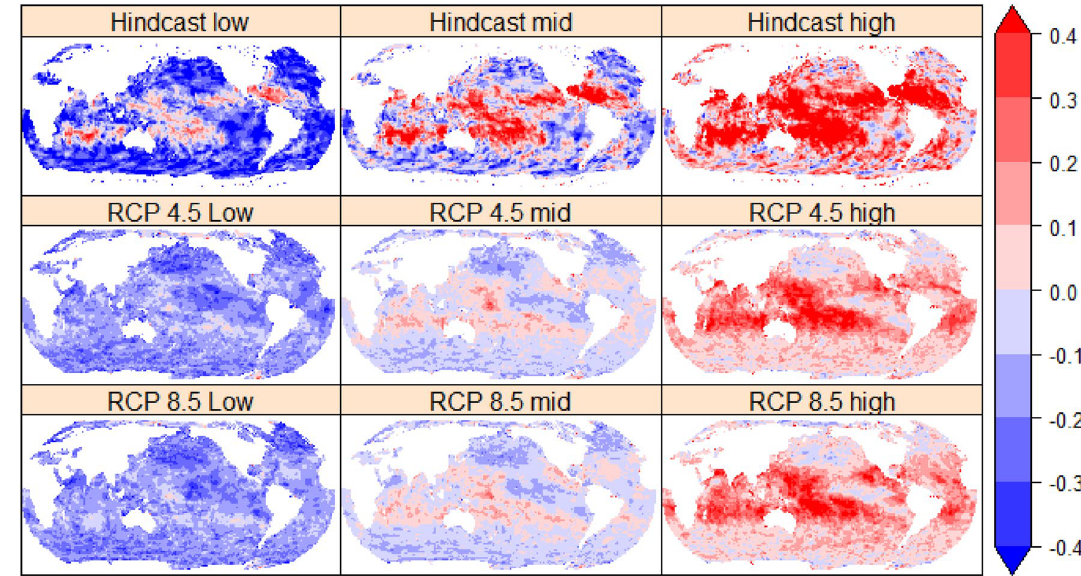
Figure 2. Estimated range of the GEV shape parameter for the full periods of the hindcast and GWCM period (combined baseline, mid and end of twenty-first Century periods) of the two RCP scenarios. Top row: hindcast. Middle: the entire GWCM RCP 4.5 period. Bottom: same as middle but for RCP 8.5. See "Methods" section for definition of estimated ranges: low, mid and high represented by the 5th, 50th, and 95th quantiles respectively. Created using the R statistical software version 4.0.2 22